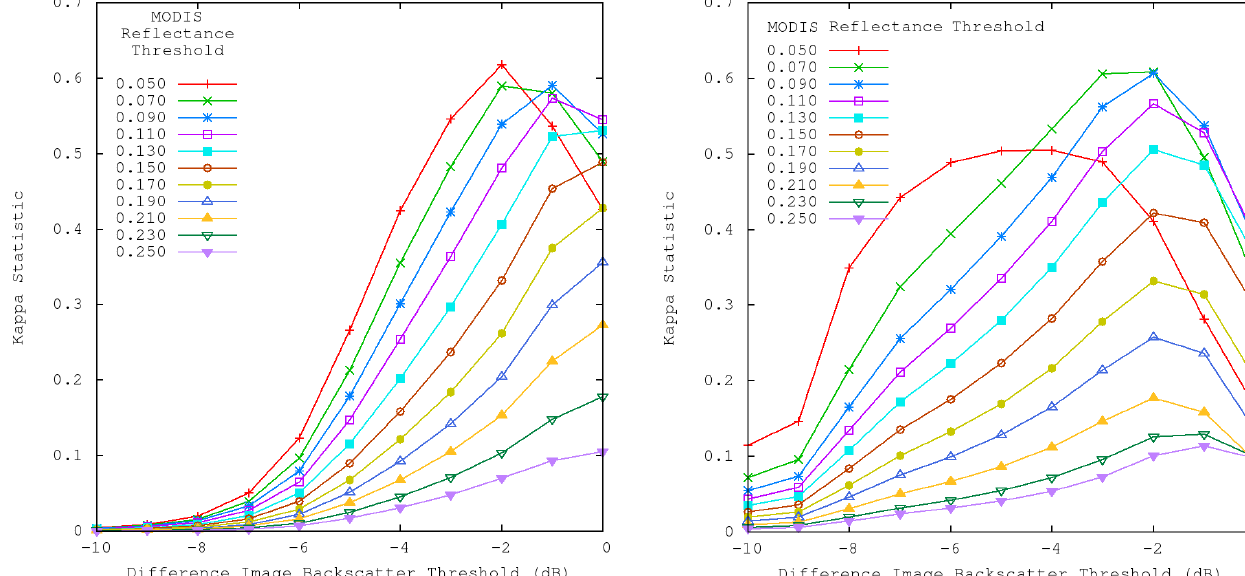
Fig. 12. κ statistic calculated for individual classifications of flood- ing on 27 August 2010, based upon 1σ 0 thresholds ranging from − 10 to 0dB. The series represents corresponding MODIS Band 6 reflectance thresholds used in the reference image, ranging from 0.05 to